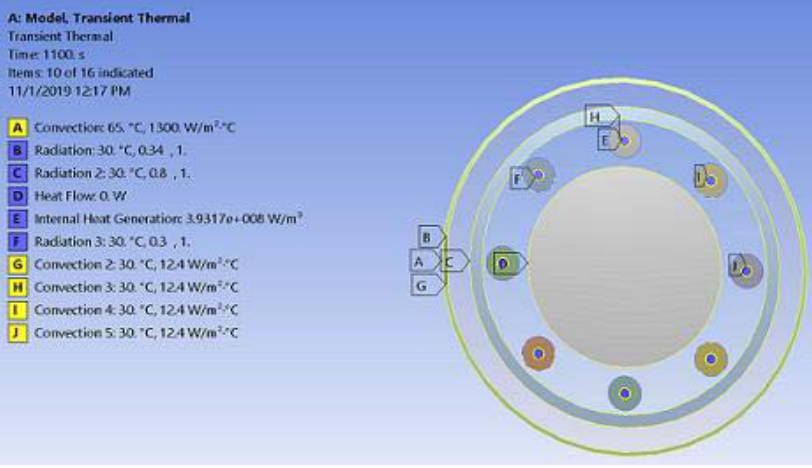
Figure 4. Boundary conditions used in